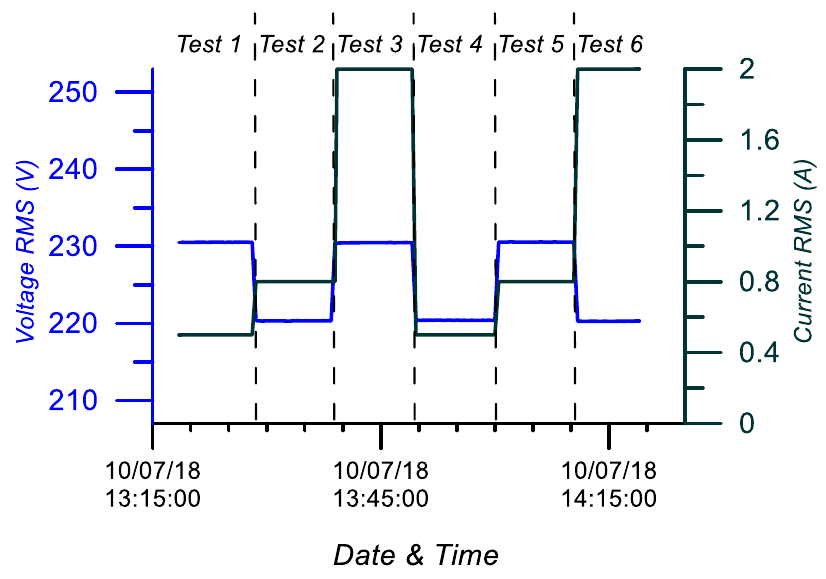
Figure 15. Voltage (blue) and current (dark green) during the long-term monitoring test.